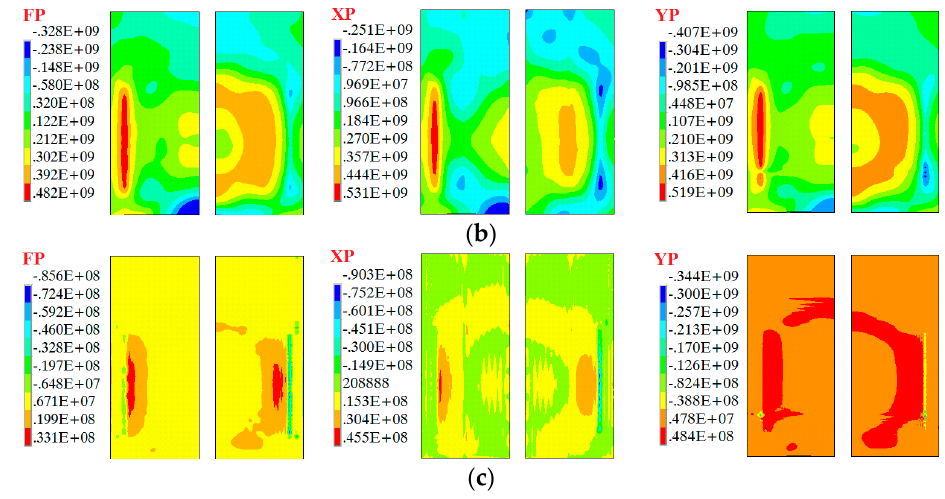
Figure 14. Normal stress components (Pa) for the webs among the four panels at t = 139 µ s in position A: ( a ) σ x ; ( b ) σ y ; and ( c ) σ z .